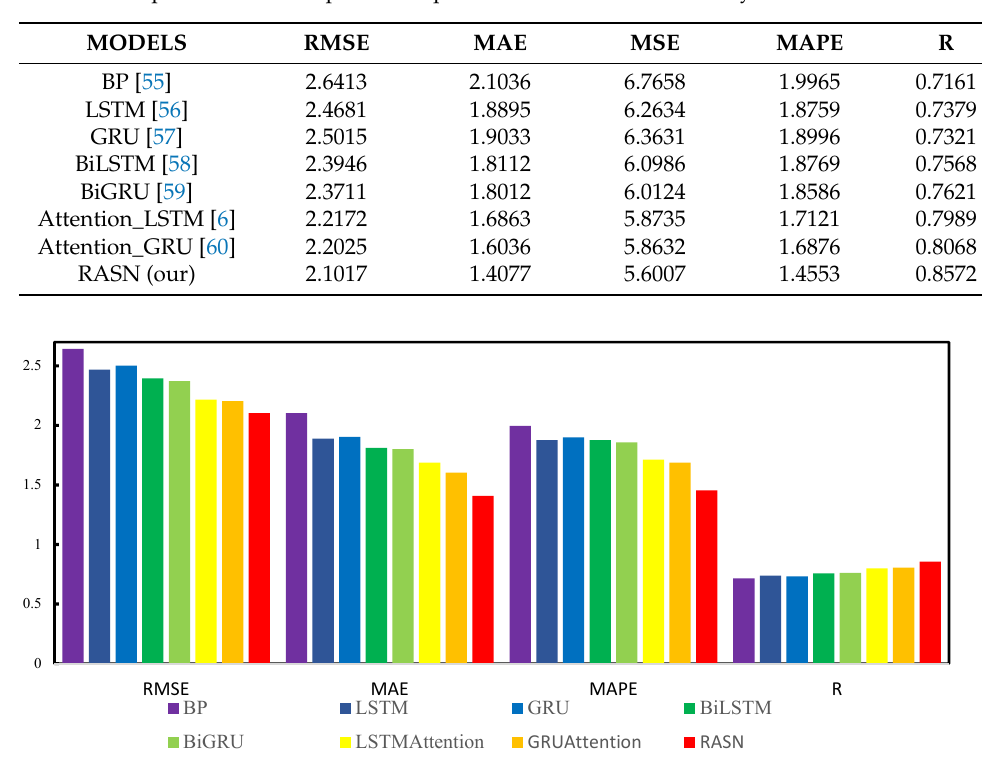
Figure 8. Comparison of experimental evaluation indexes for humidity prediction.